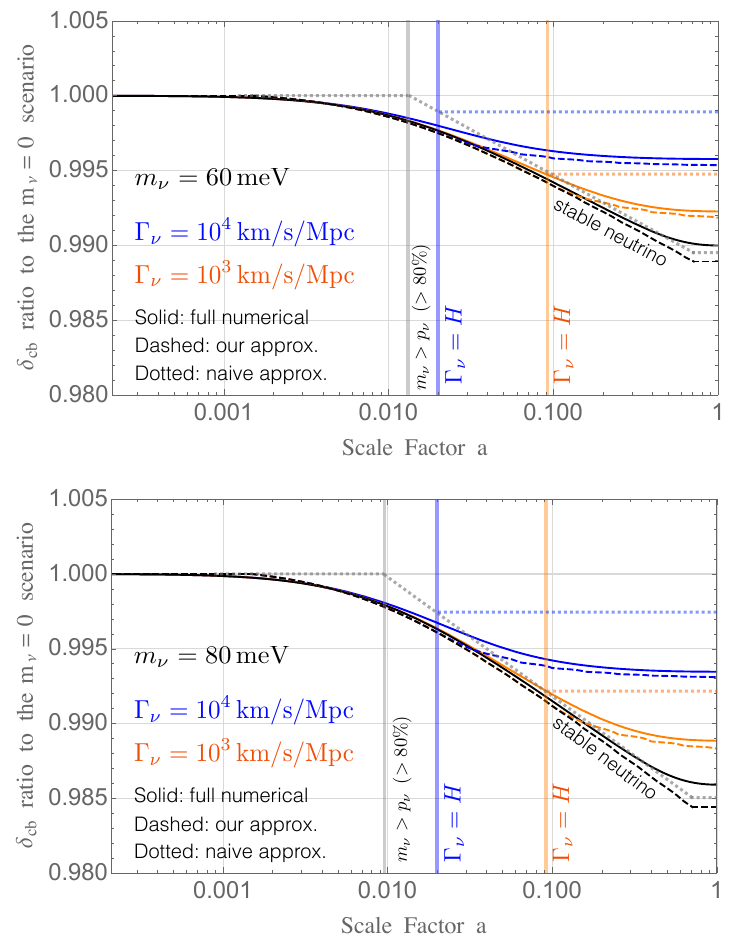
Figure 5 . Evolution of the ratio of the CDM+baryon density perturbation with respect to the case of a massless neutrino, (cid:14) m (cid:23) =(cid:14) 6 m (cid:23) . The results are shown for the case of a single massive neutrino cb cb with m (cid:23) = 60 meV. All the solid curves are obtained from numerical calculations using the modi(cid:12)ed CLASS code discussed in section 3. The black curve is for the stable neutrino scenario, and the blue (orange) curve is for the neutrino with decay rate (cid:0) (cid:23) = 10 4 (10 3 ) km /s/Mpc. The dashed curves represent the (cid:12)rst approximations to the solid curves, based on the derivation in eq. (4.14). The dotted curves are based on the approximation method in eq. (4.15), where we assume a i to be the value when 80% of neutrinos have their momenta lower than m (cid:23) and a f = a dec . As we see, eq. (4.14) provides a much better approximation to the full numerical